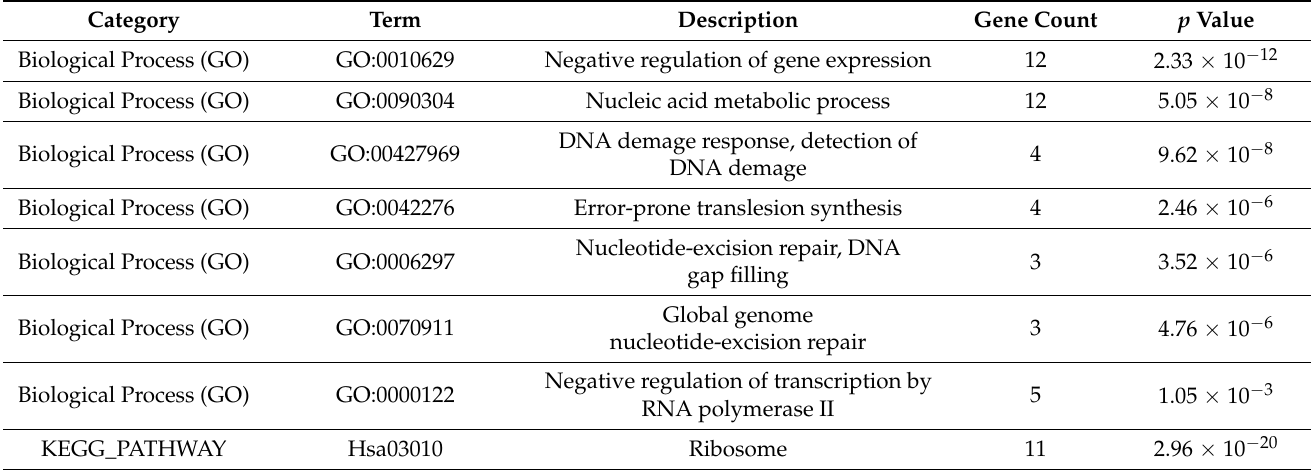
Table 1. The top 15 hub genes enrichment with GO and